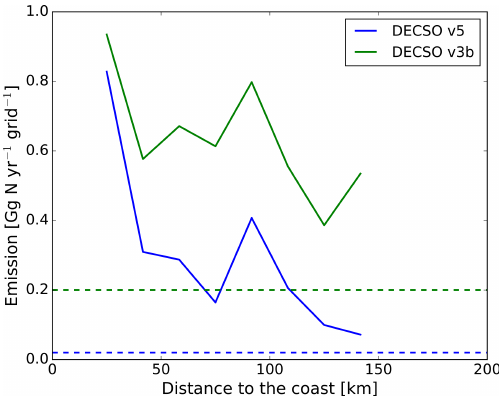
Figure 9. The relation between NO x emissions over the ocean and the distance to the coastline in the Taiwan Strait (the quadrilateral area in Fig. 7). The blue dashed line is the background noise in DECSO v5 and the green dashed line in DECSO